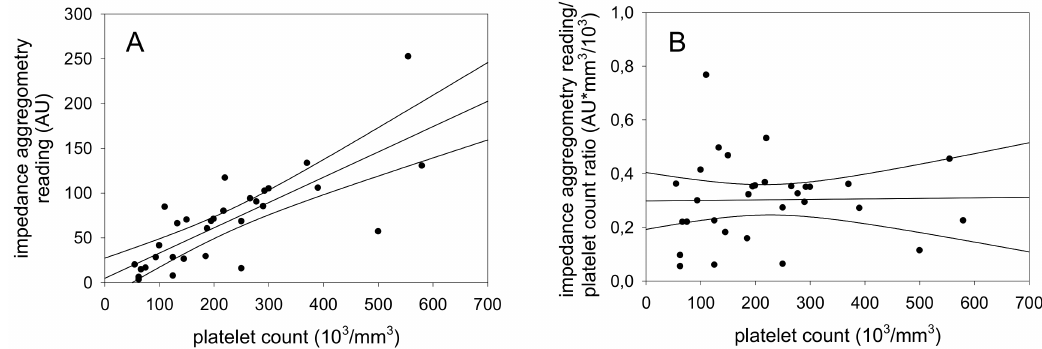
Figure 1. ( A ) The e ff ect of platelet count on the impedance aggregometry reading and ( B ) the ratio of the impedance aggregometry reading and platelet count. Platelet-rich plasma samples were diluted with platelet-poor plasma to obtain di ff erent platelet counts. Impedance aggregometry readings were correlated with platelet count (n = 31, r = 0.78, p = 0.0001, power = 0.99). In contrast, the ratio of the impedance aggregometry reading and platelet count was independent of platelet count and thus specific for platelet function (n = 31, r = 0.16, p = 0.4). Shown are individual data points as well as linear regression lines and 95% confidence intervals.